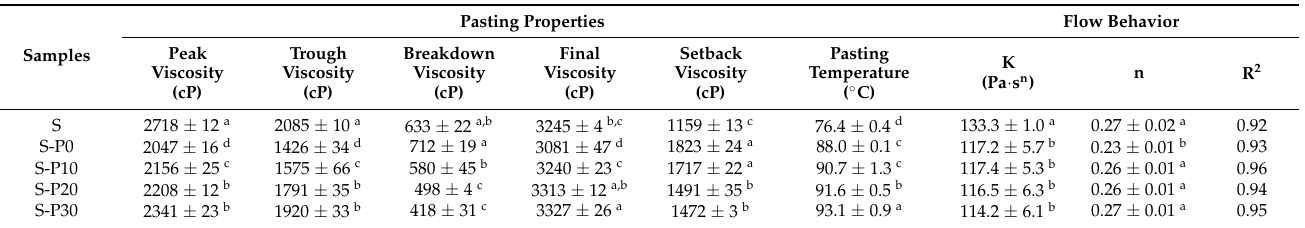
Table 2. The pasting properties and flow behavior of rice starch, and rice starch blended with protein or homogenized